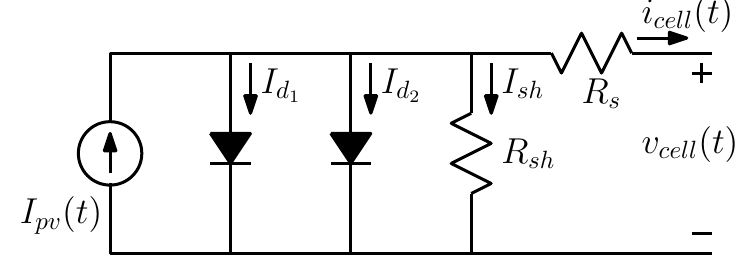
Figure 1. Circuital schemes of the single-diode model for representing PV